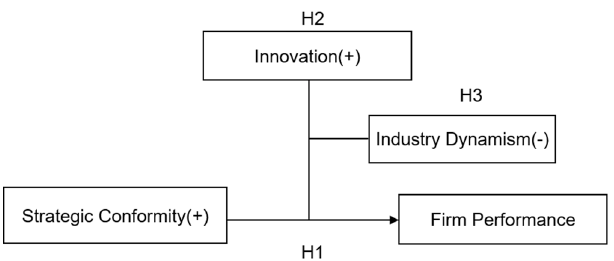
Figure 1. Research model.